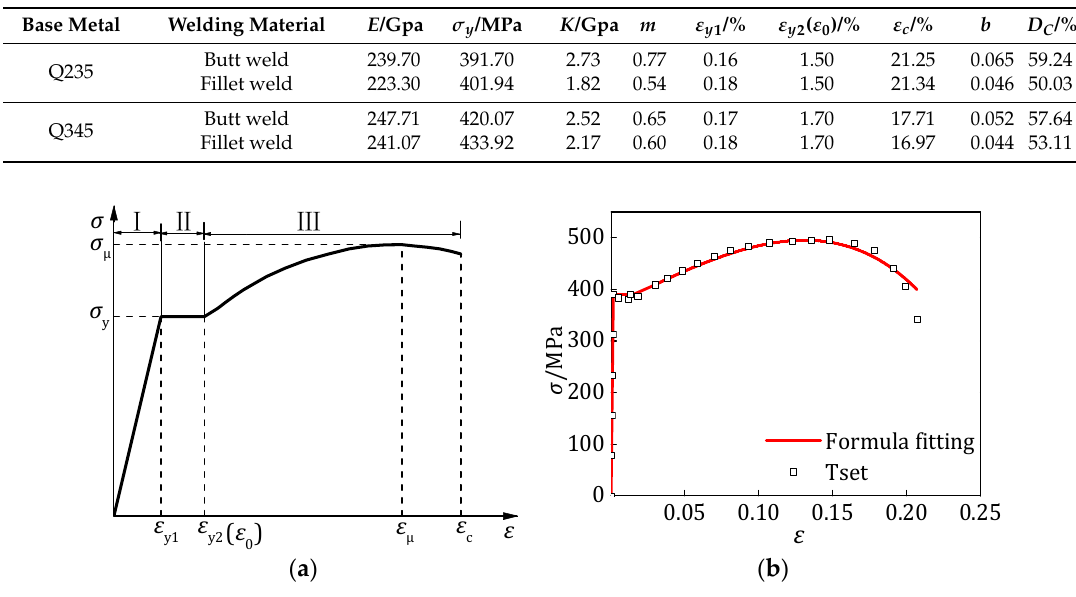
Figure 11. Fitting results of the initial loading curve. ( a ) The schematic diagram of the initial loading curve; ( b ) Fitting result of the WA1 specimen.